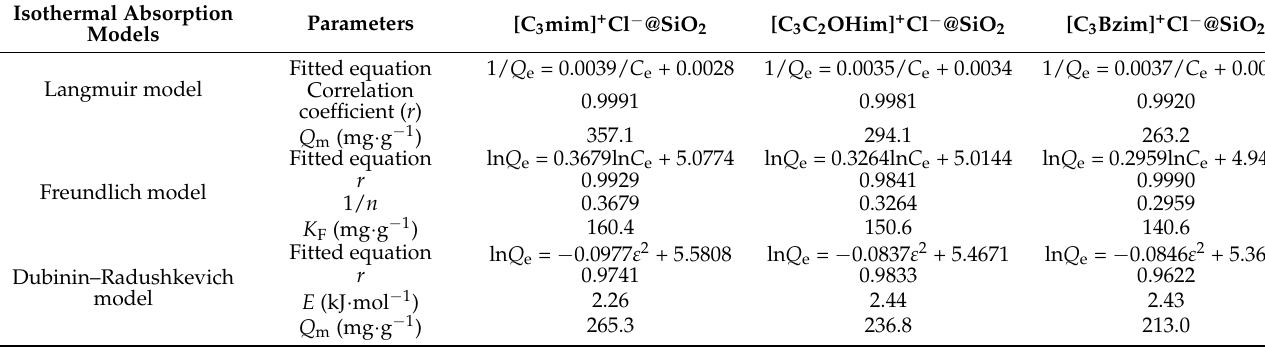
Table 1. Isotherm model parameters for the adsorption of baicalin onto ILs grafted silica (pH 5.0, 25 ◦ C). Isothermal Absorption